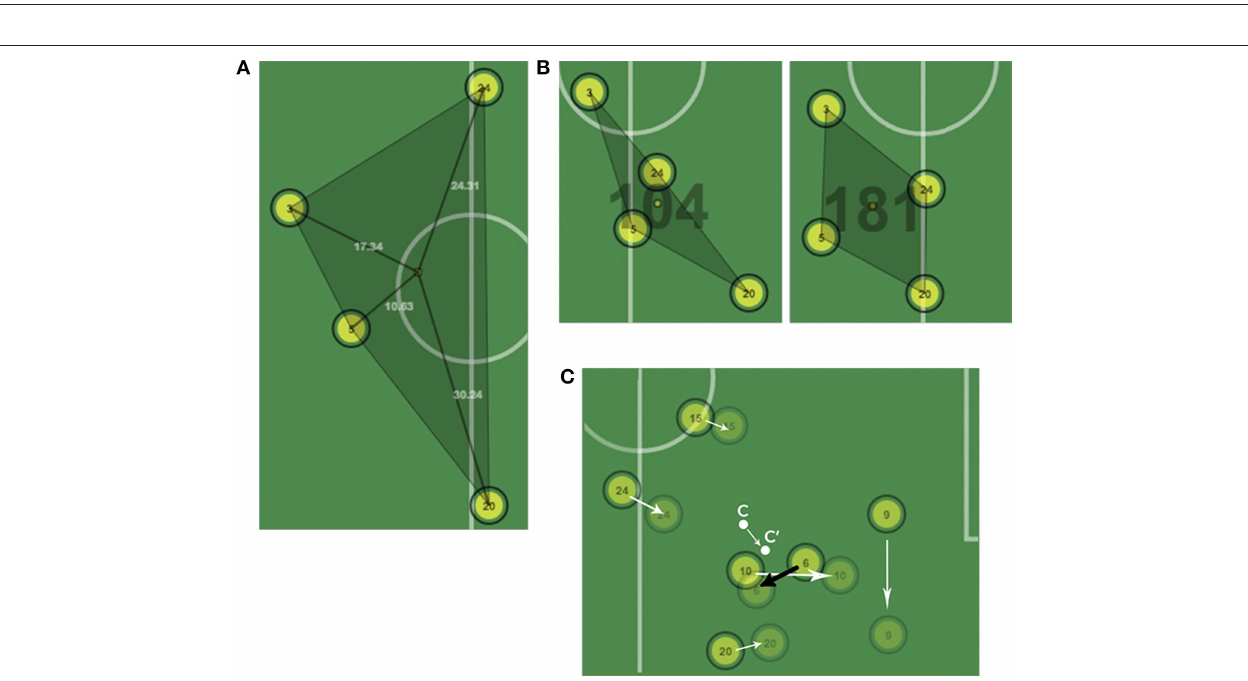
FIGURE 2 | (A) Centroid of a group of players with radial distances. (B) The same group of players captured at two different instants of the game. Despite being equally dispersed, the players on the right covered a larger effective playing space. (C) Intra-group coordination in a series of movements. Player number 6 performs in the opposite direction of his